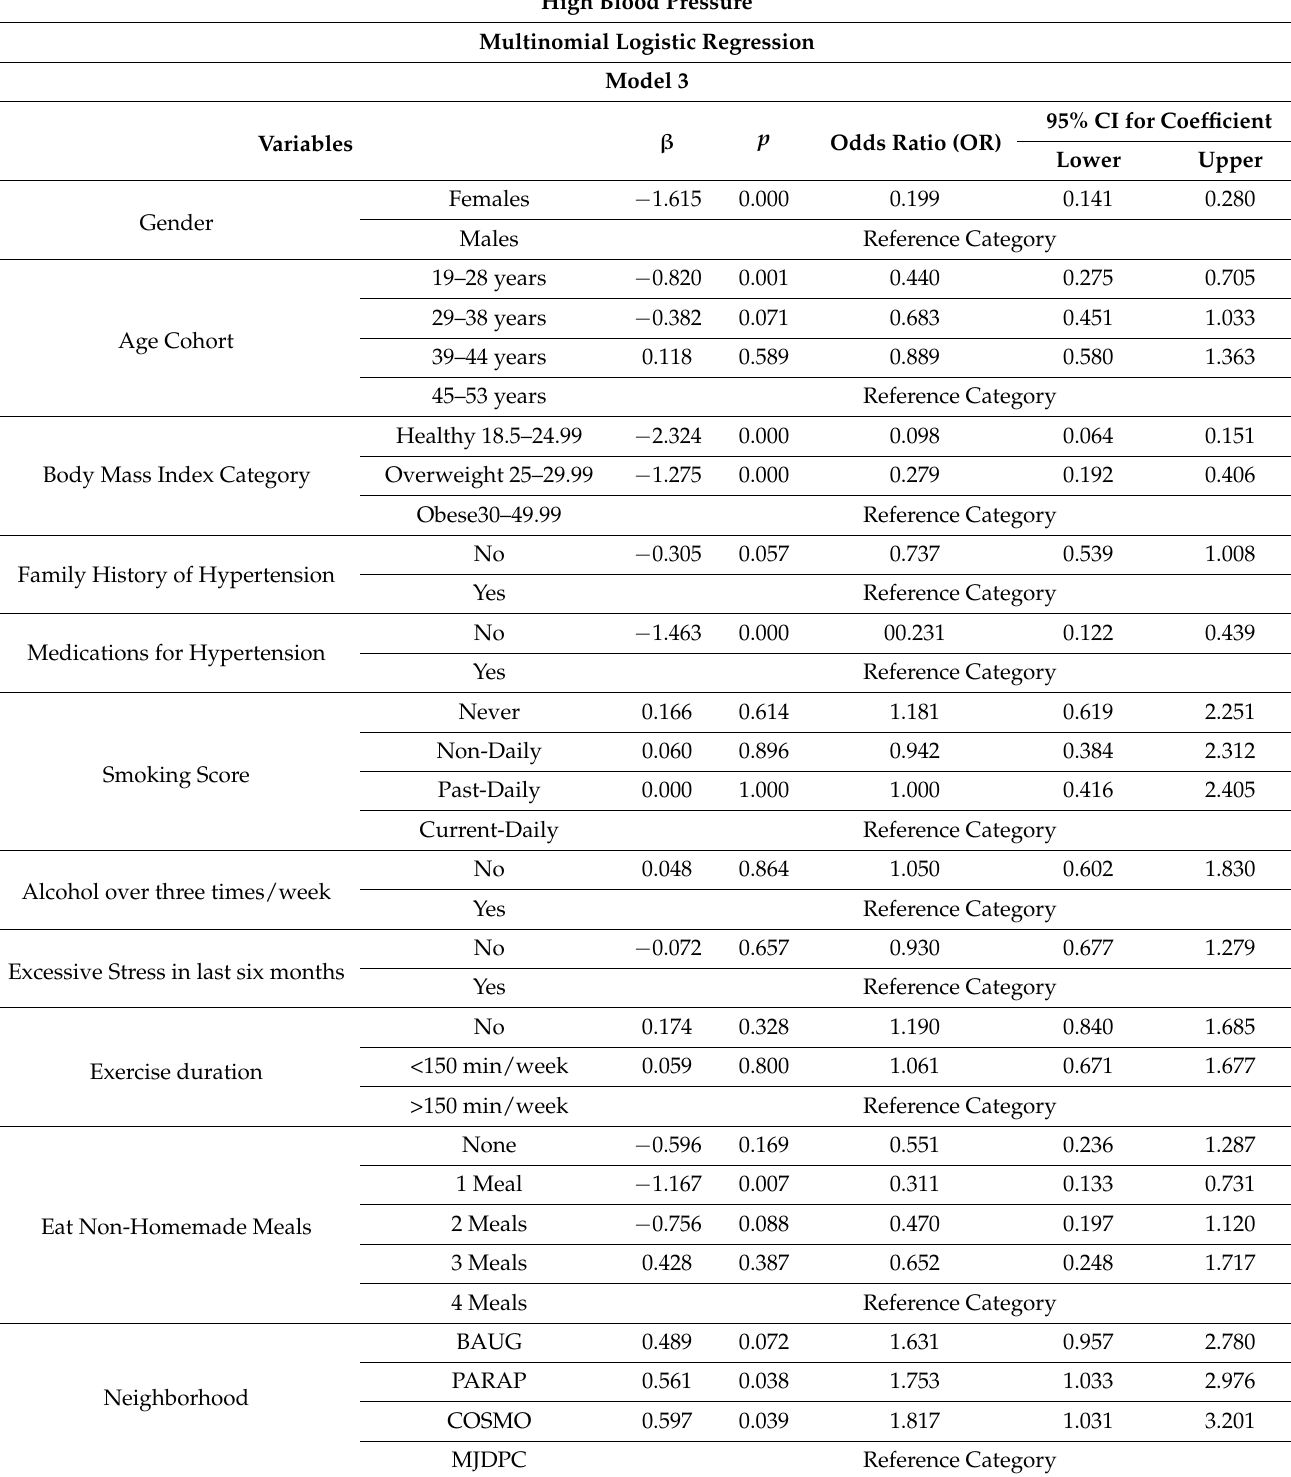
Table 6. Multinomial logistic regression for high blood pressure and